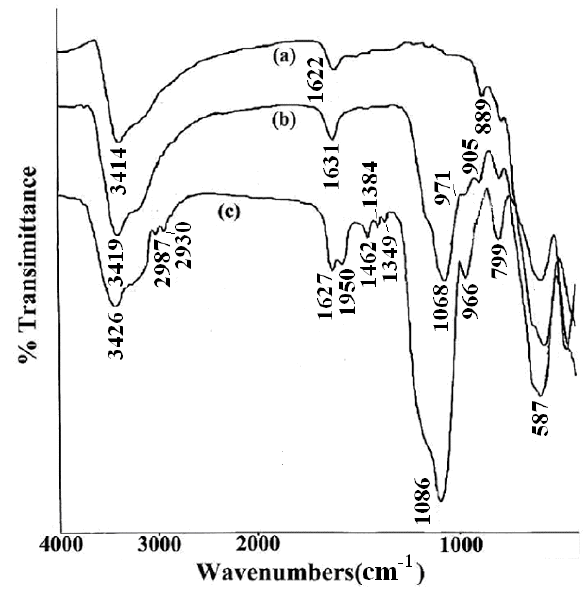
Figure 4. FTIR spectra of ( a ) Fe 3 O 4 nanoparticles; ( b ) SMN and ( c ) DAPD-SMN.